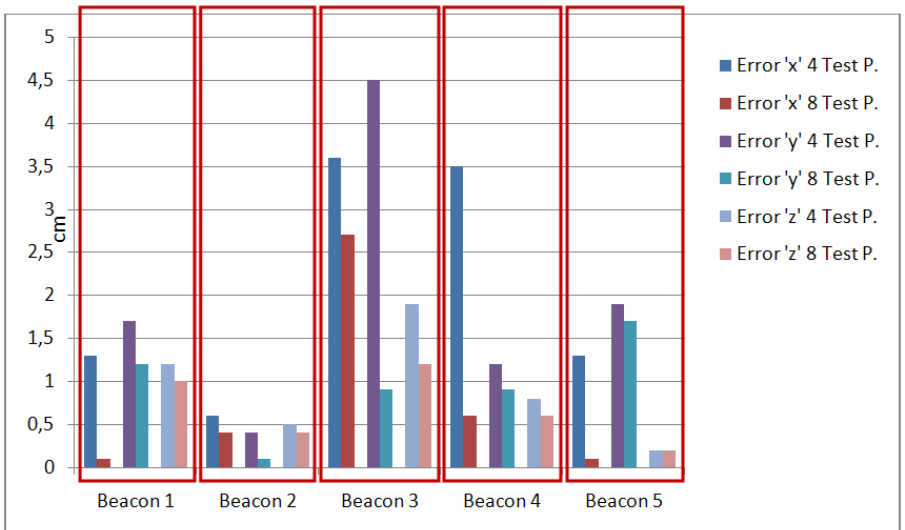
Figure 9. Average absolute error in every component for the calibrated beacons (spherical case).